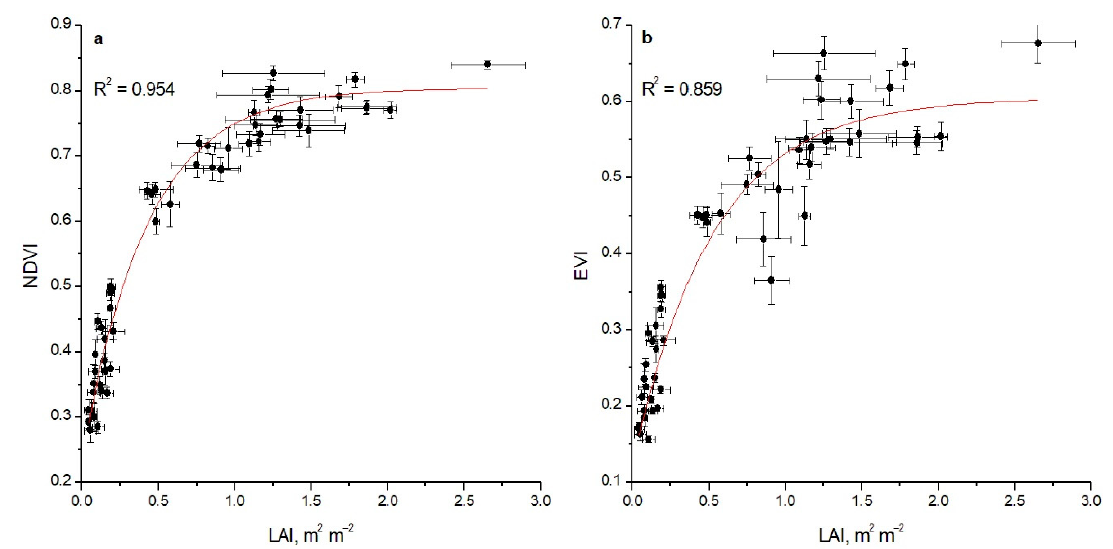
Figure 6. Relationships between field-measured LAI and Sentinel-2 NDVI ( a ) and EVI ( b ). Data concern dates with both. acquisitions and field measurements. Each point corresponds to the mean from three LAI measurements performed in one plot at one date and the mean from the corresponding nine Sentinel-2 pixels ± standard deviation.